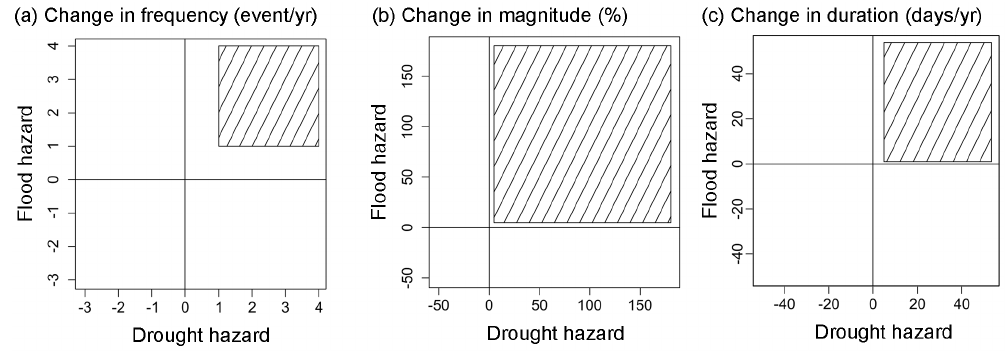
Figure 3. Selection of hot-spots based on changes in (a) frequency, (b) magnitude, and (c) duration of both flood and drought hazards (dashed